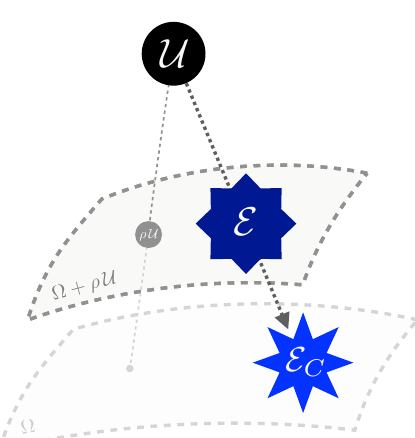
Figure 8 . A visualization of pileup subtraction in the space of events as moving away from uniform radiation. This proceeds by (cid:12)nding the event that, when combined with uniform contamination E C (cid:26) , is most similar to the given event . Di(cid:11)erent pileup mitigation strategies implement this U E removal in di(cid:11)erent ways. In the (cid:12)gure above, (cid:10) refers to the space of all energy (cid:13)ows and (cid:10) + (cid:26) U is a subset of that space obtained by adding uniform contamination to every event con(cid:12)guration (shown as a separate manifold for ease of